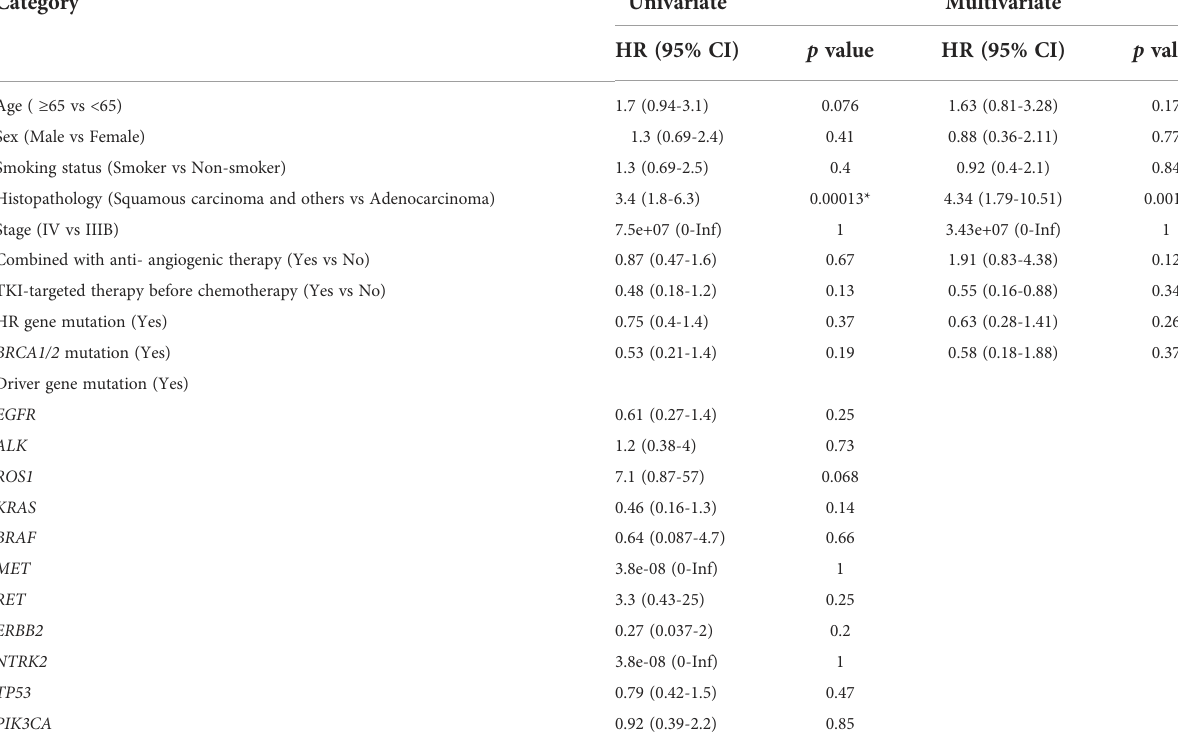
TABLE 4 Univariate and multivariate Cox proportional hazard regression analysis of potential factors associated with overall